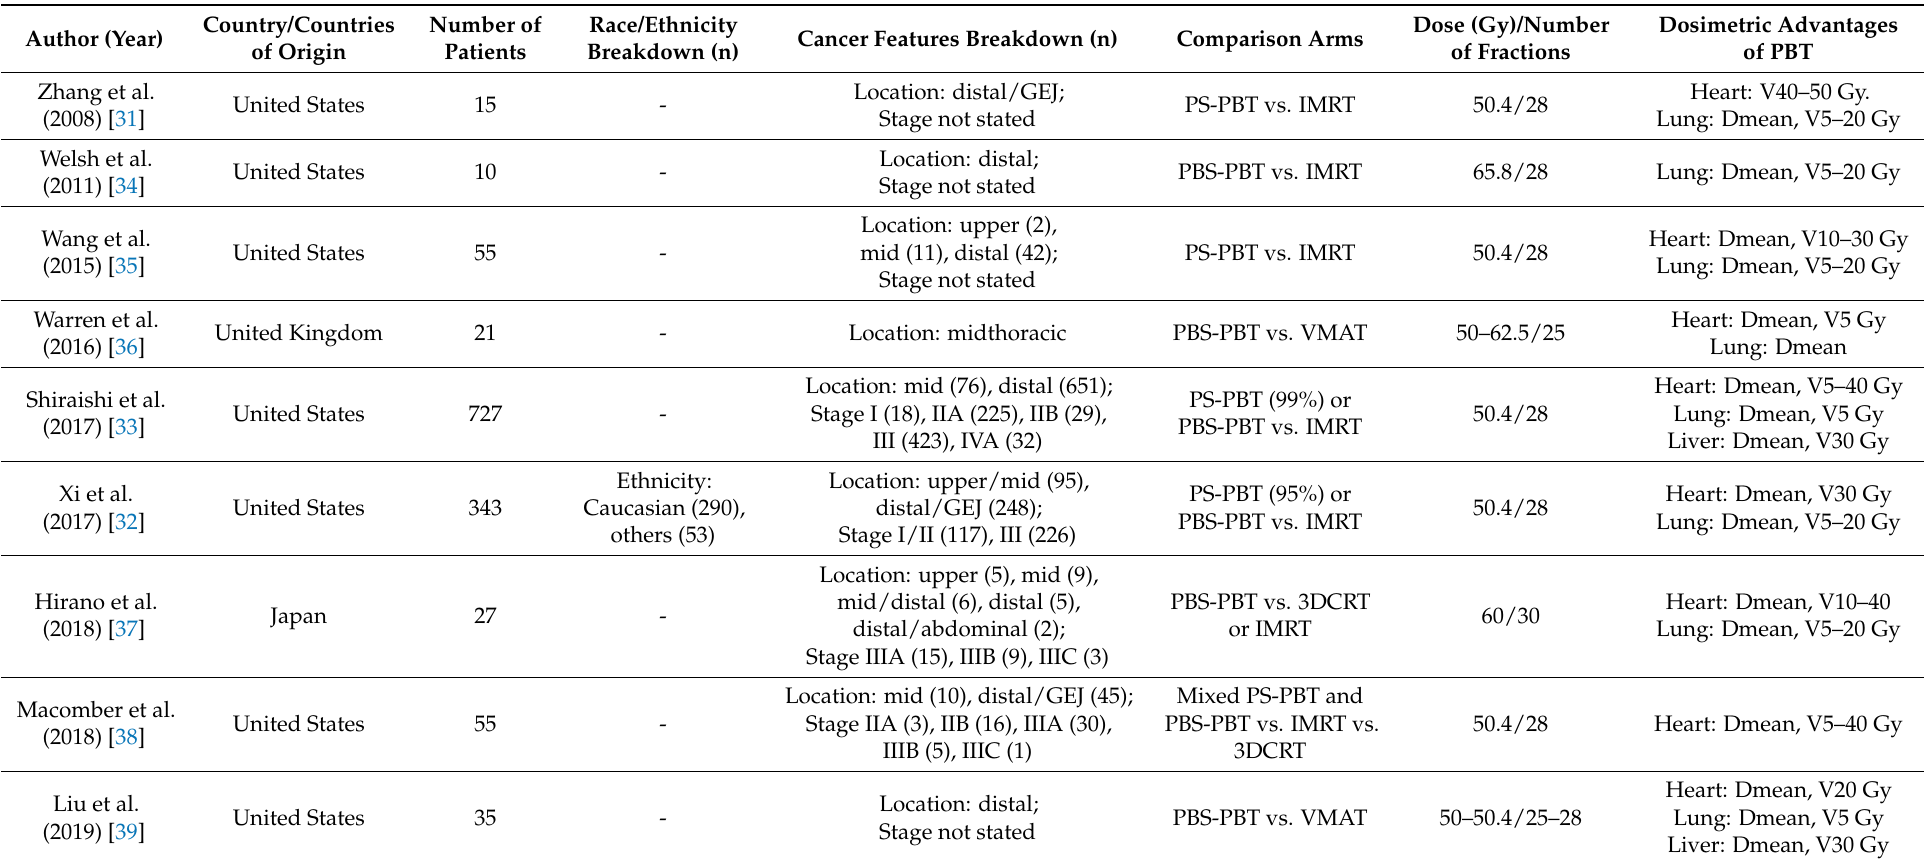
Table 1. Dosimetric studies comparing photon-based and proton beam therapy techniques for esophageal cancer treatment. This table builds upon studies reviewed in Jethwa et al. (2020)